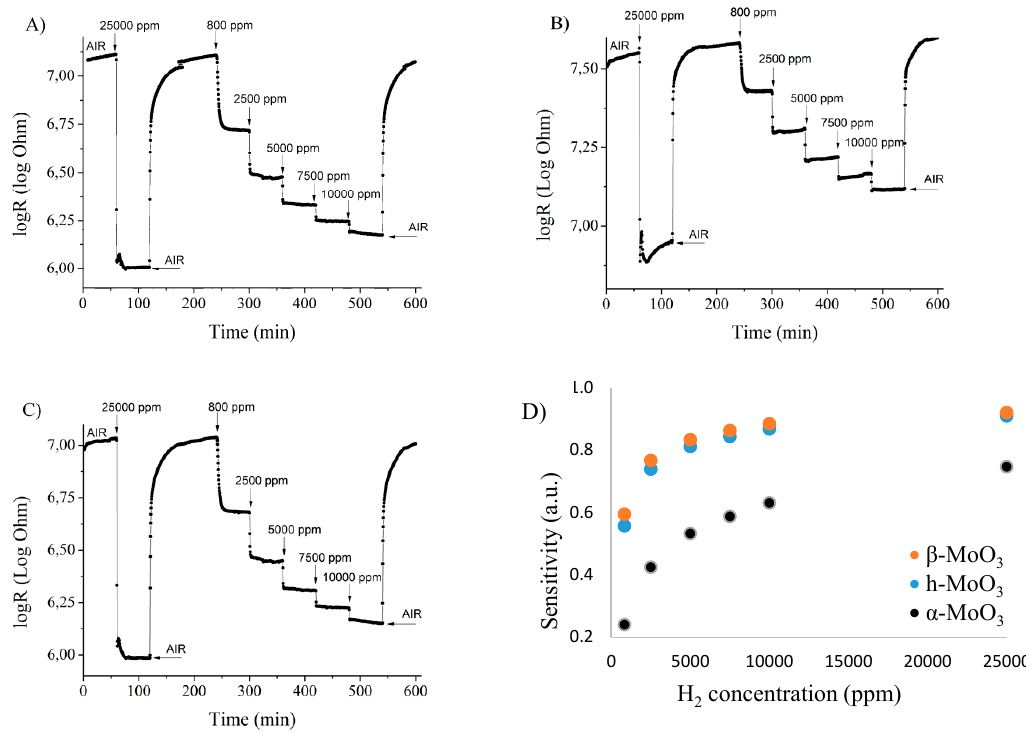
Figure 7. Results of the gas sensing test of the different MoO 3 phases. ( A ) MoO 3 -10, monoclinic phase (CrCl 3 , 240 °C, 6 h); ( B ) MoO 3 -8, orthorhombic phase (CTAB, 240 °C, 6 h); ( C ) MoO 3 -1, hexagonal phase (90 °C, 3 h); ( D ) sensitivity of the MoO 3 polymorphs. Table 3. Response and return times of sensors using 25,000 ppm H 2 .